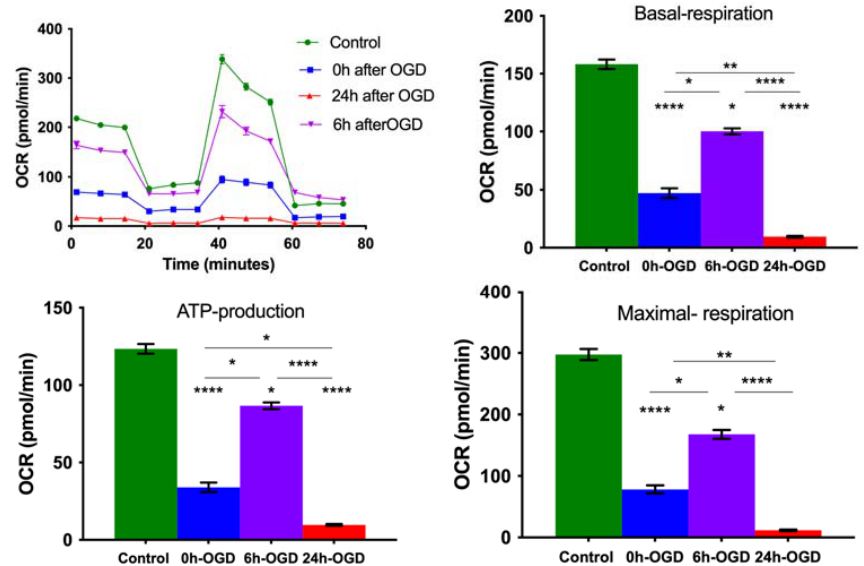
Figure 2. Measurement of mitochondrial respiration (OCR) and quantification of OCR. Bar graphs expressed as mean ± SEM calculating the difference between control, immediately after OGD and 24 h after OGD. * p ≤ 0.05, ** p ≤ 0.01; **** p ≤ 0.0001. Statistics compared by Kruskal–Wallis followed by Dunn’s multiple comparisons. The data are for Control 0 h-OGD 6 h-OGD 24 h-OGD for at least 20 wells per condition.